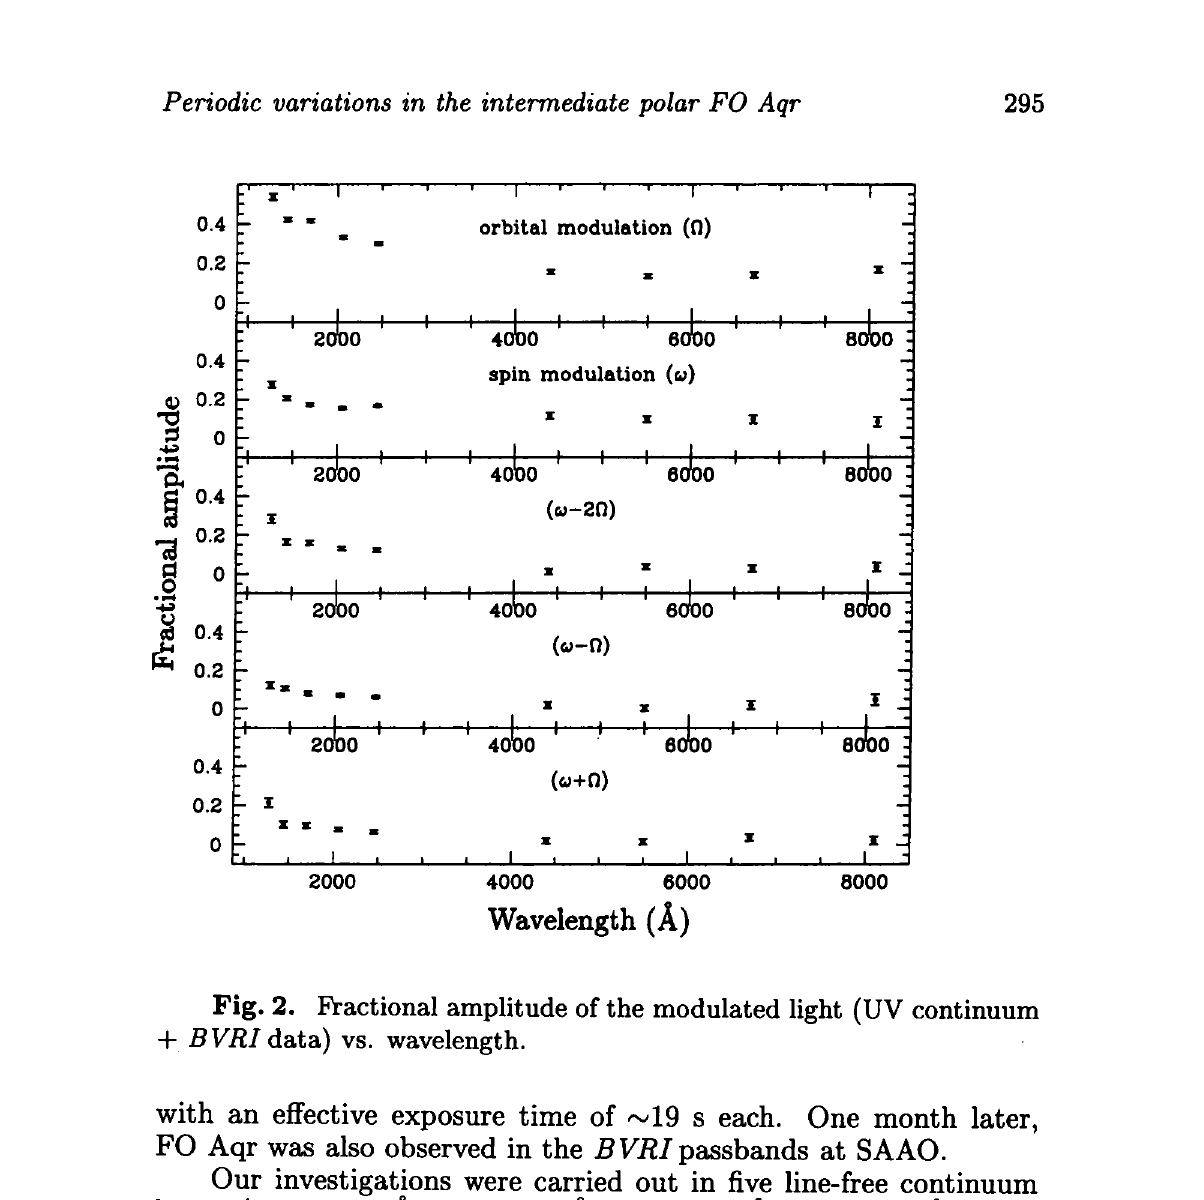
Fig. 2. Fractional amplitude of the modulated light (UV continuum + BVRI data) vs.